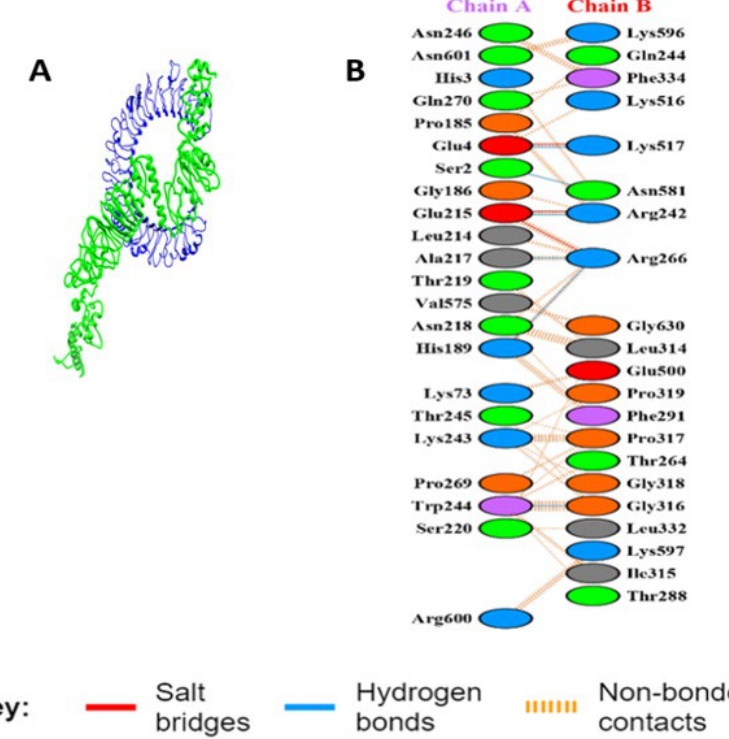
Figure 4. The feature showing ( A ) the docked complex of MEV (green) and TLR3 (blue) and ( B ) the residue interactions of TLR3 (chain A) and MEV (chain residue interactions of TLR3 (chain A) and MEV (chain B).